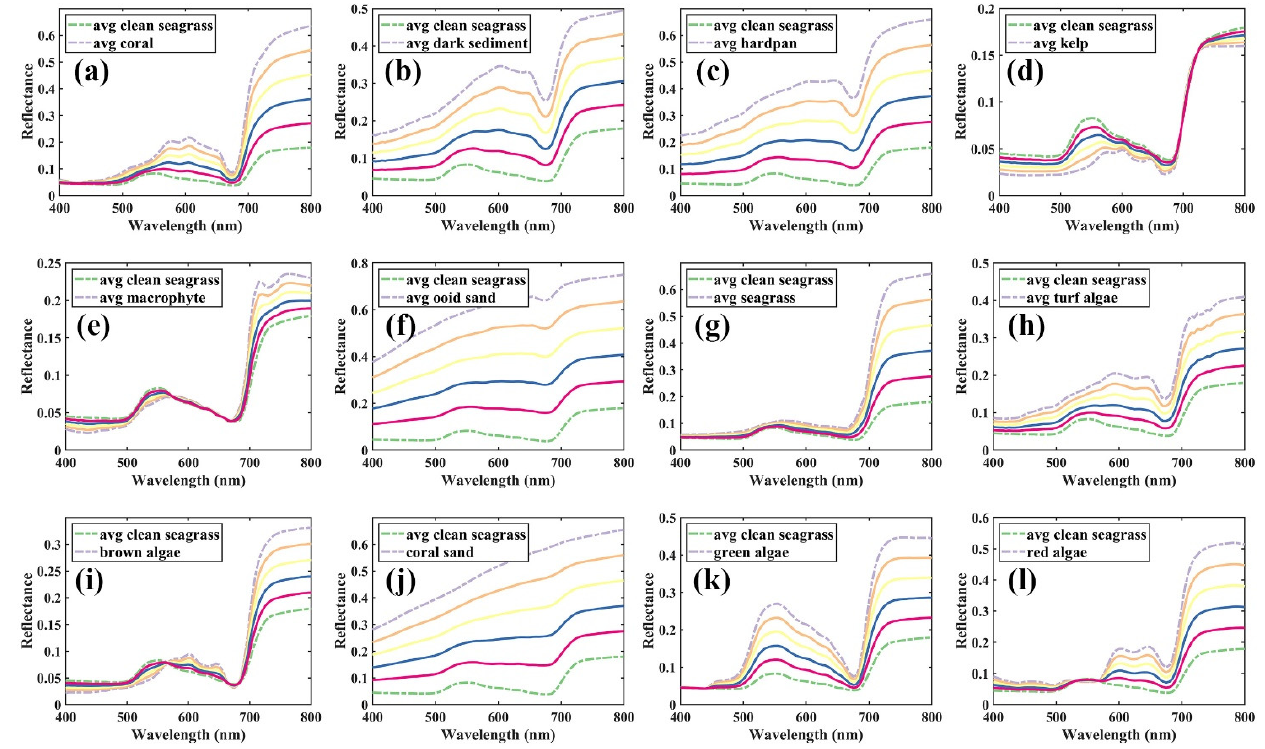
Figure 2. An example of the mixture of two bottom types with 20%, 40%, 60%, and 80% fractions. One of the bottom types is the clean seagrass (green dashed line), and the other one is the rest of the sediment from HE5 (purple dashed line), ( a ) coral, ( b ) dark sediment, ( c ) hardpan, ( d ) kelp, ( e ) macrophyte, ( f ) ooid sand, ( g ) seagrass, ( h ) turf algae, ( i ) brown algae, ( j ) coral sand, ( k ) green algae, ( l ) red algae. The solid lines from top to bottom represent the mixed endmembers with the proportion of clean seagrass from 20% to 80% with 20% steps.